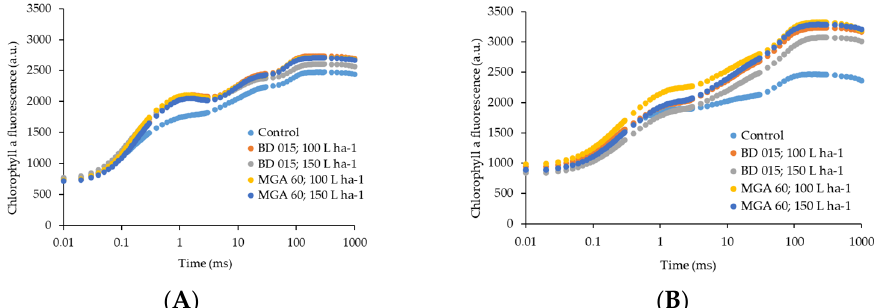
Figure 1. The OJIP chlorophyll a fluorescence transient (log time scale) in coffee leaves exposed to light stress. The measurements were made after 7 ( A ) and 30 days ( B ) of treatment. Before the measurements, leaves were dark-adapted for 30 min. Values are means for eight plants. The JIP-test parameters can be used to characterize the behavior of PSII in response to di ff erent types of external environmental stresses, such as heat and light intensity [24]. In this study, the variables describe about the absorbed energy fl ux (ABS/RC) and the en- ergy fl ux captured by CR (reaction center) at t = 0 (TR 0 /RC) did not di ff er ( p > 0.05) between control and treatments after 7 days of sunscreen application in the di ff erent spray nozzles. However, increased values ( p ≤ 0.05) of ABS/RC and TR 0 /RC were obtained after 30 days of sunscreen application on conilon co ff ee seedlings (Figure 2A,B).